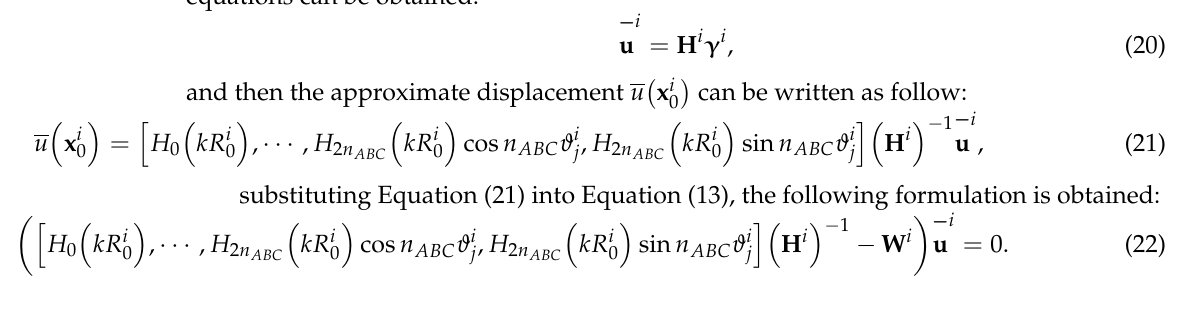
Table 1. Numerical errors (L 2 ) in the reliable region obtained by the proposed localized collocation Trefftz method (LCTM) + absorbing boundary conditions (ABC) with respect to the increasing node number and wavenumber.